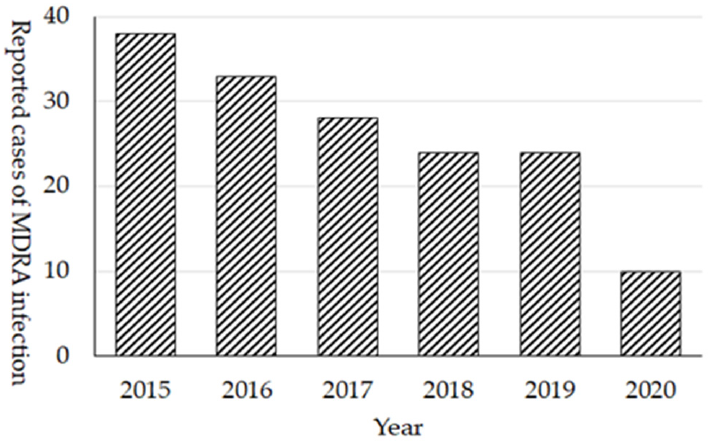
Figure 7. Number of reported cases of MDRA infecion, NESID 2015 to 2020.